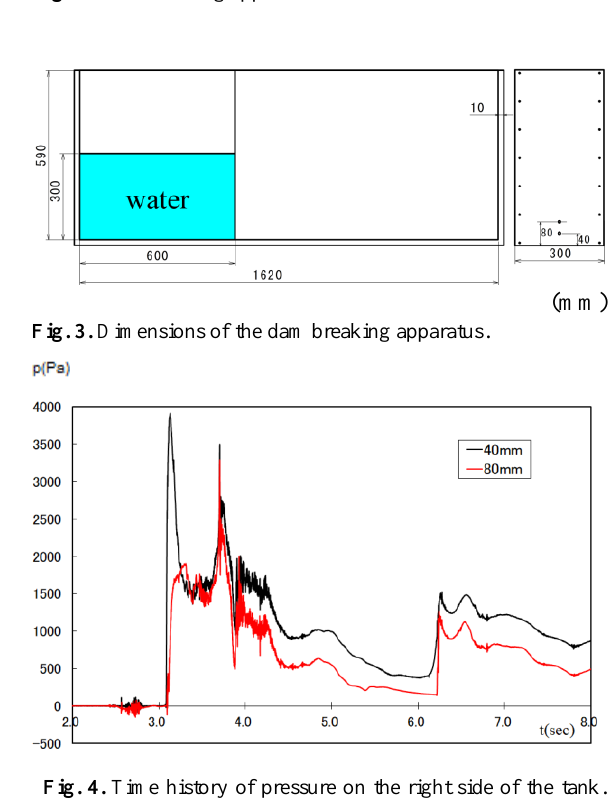
Fig. 2. Dam breaking apparatus overview .